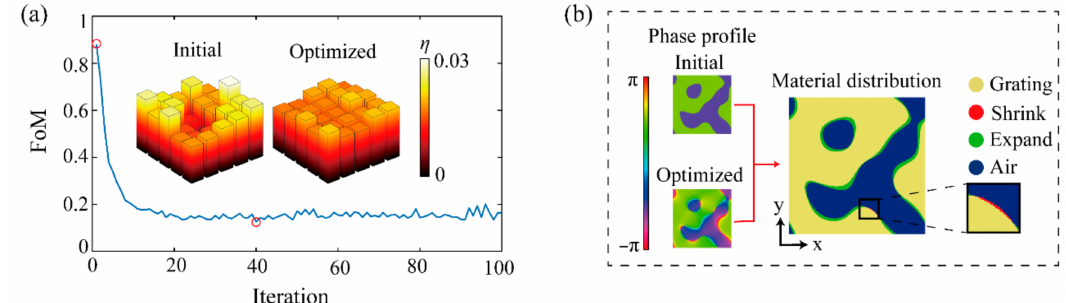
Figure 2. The optimization process of 5 × 5 beam splitter. ( a ) FoM as a function of the iteration in the optimization of the 5 × 5 beam splitter with a maximal diffraction angle of ± 35 ◦ . The iteration step where the initial solution and the optimal solution are obtained are both marked by the red circles. The bar charts represent the diffraction efficiency of each order from the initial solution and the optimal solution, respectively. ( b ) The phase profiles of the initial and the optimal solution, and the changes in the material distribution from the initial solution to the optimal solution. The red arrow means the operations of structural modeling and comparison. The air, the grating structure and its changes are marked in different colors. The yellow and the blue parts indicate the material distribution remains unchanged after optimization. The green parts mean the grating structure expands to where there was air previously, while the red part, which is magnified to facilitate the observation, indicates the grating structure shrinks after the optimization.